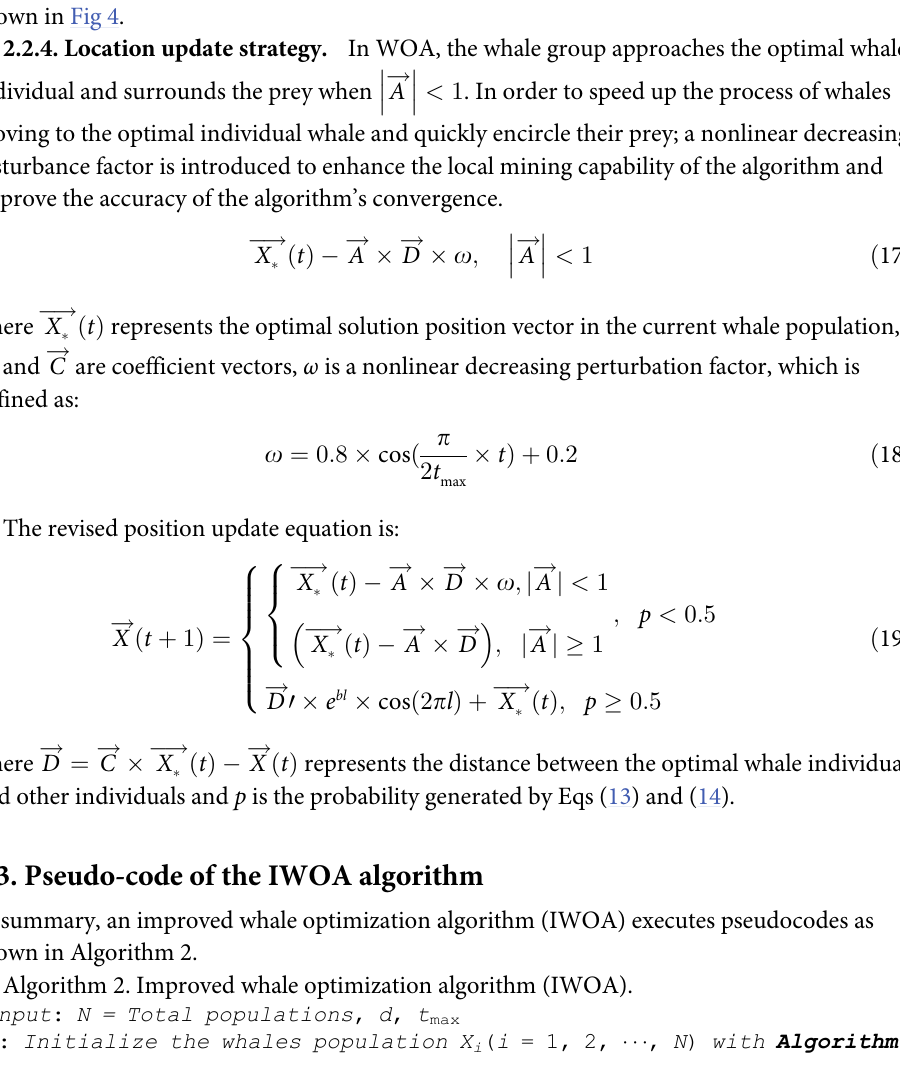
Fig 4. Modified parameter a -value, A